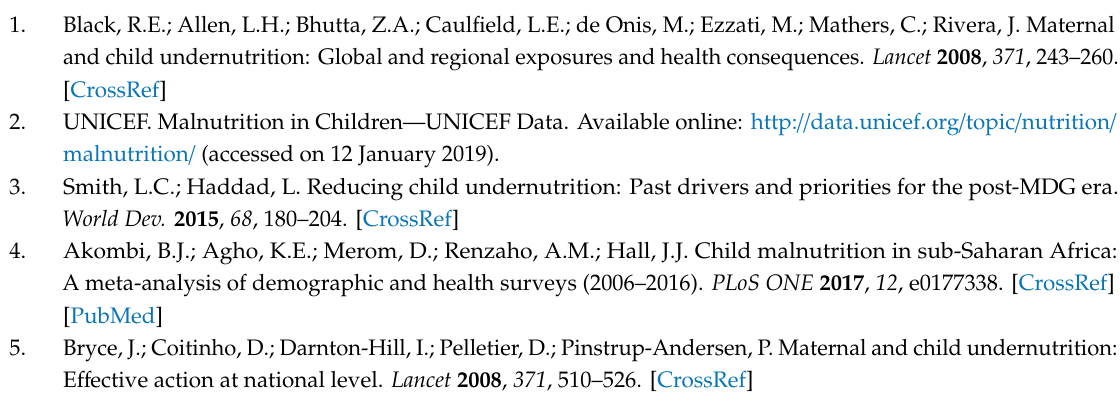
Table S1: Increments in young child LAZ (6–23 mo) predicted by JMP water supply indicators and frequent diarrheal episodes in East